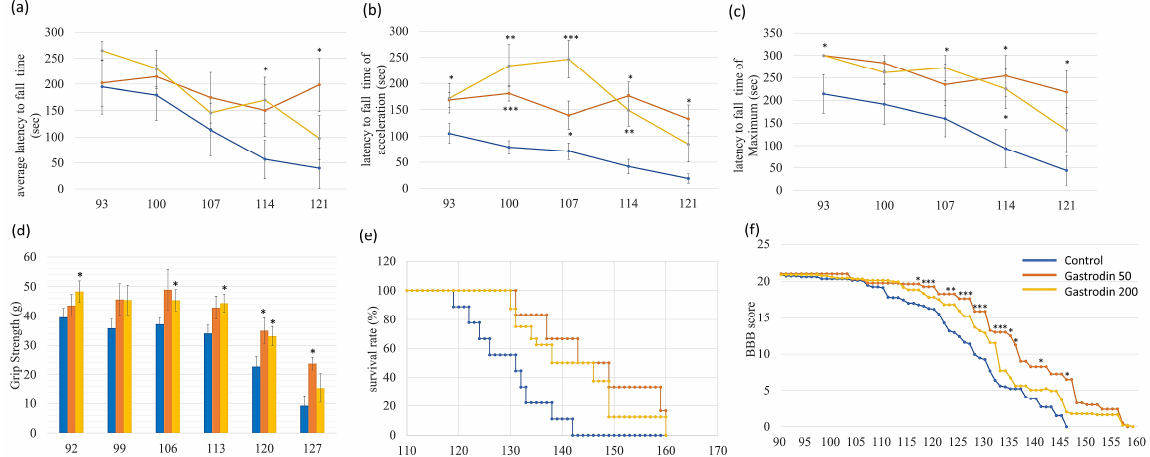
Figure 7. Gastrodin improves the motor function and prolongs the life span of SOD1 G93A ALS mice. ALS mice were treated with gastrodin from 60 days of age. Data on the rotarod test ( a – c ), grip strength ( d ), survival rate ( e ), and BBB score ( f ) were recorded from 90 days-of-age. Rotarod data are presented as the average latency to fall time ( a ), latency to fall time of acceleration ( b ), and latency to fall time of maximum ( c ). * p < 0.05, ** p < 0.01, and *** p <